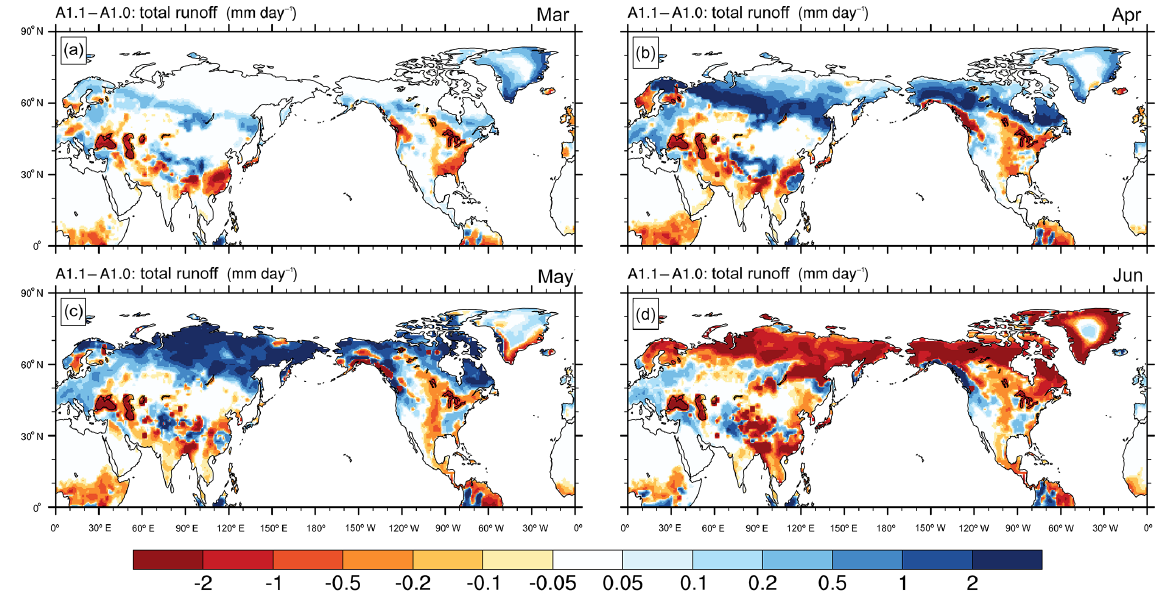
Figure 12. Monthly mean total runoff (mm/day) difference between ACCESS1.1 and ACCESS1.0 AMIP simulation for (a) March, (b) April, (c) May, and (d)